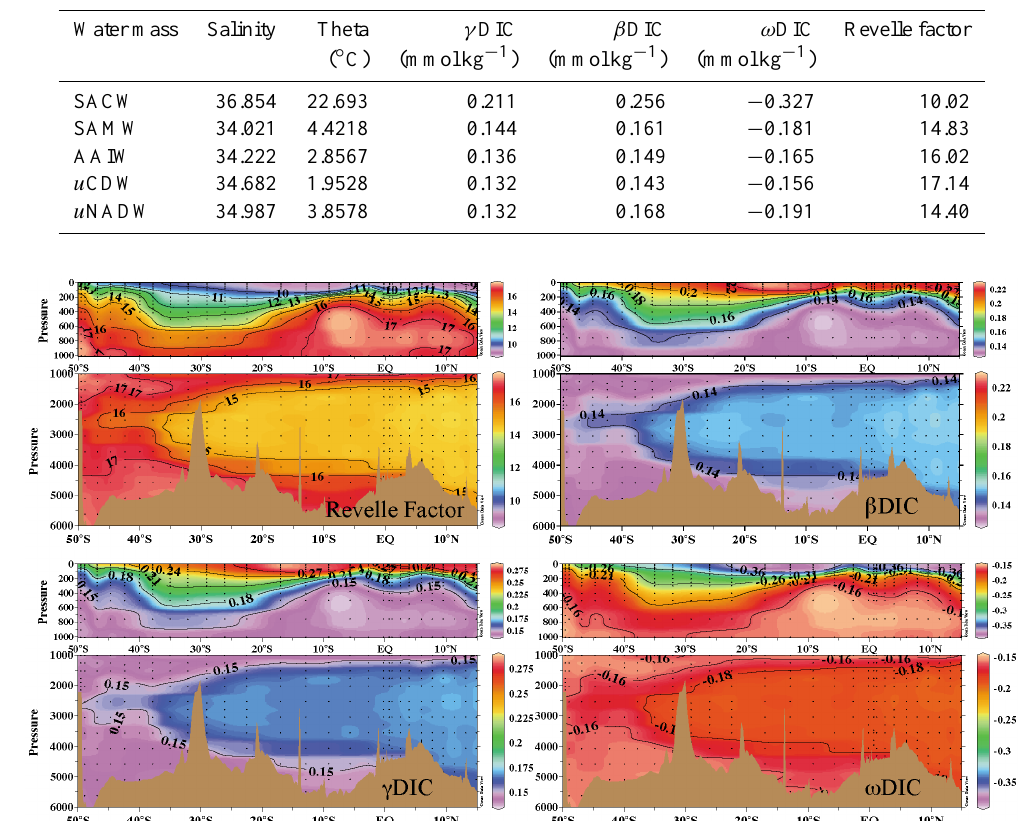
Figure 5. Distribution of the Revelle factor across the section (top left) and the three buffering factors relating to DIC: β DIC (top right), γ DIC (bottom left) and ω DIC (bottom right). The latter three are all given in mmolkg − 1 .